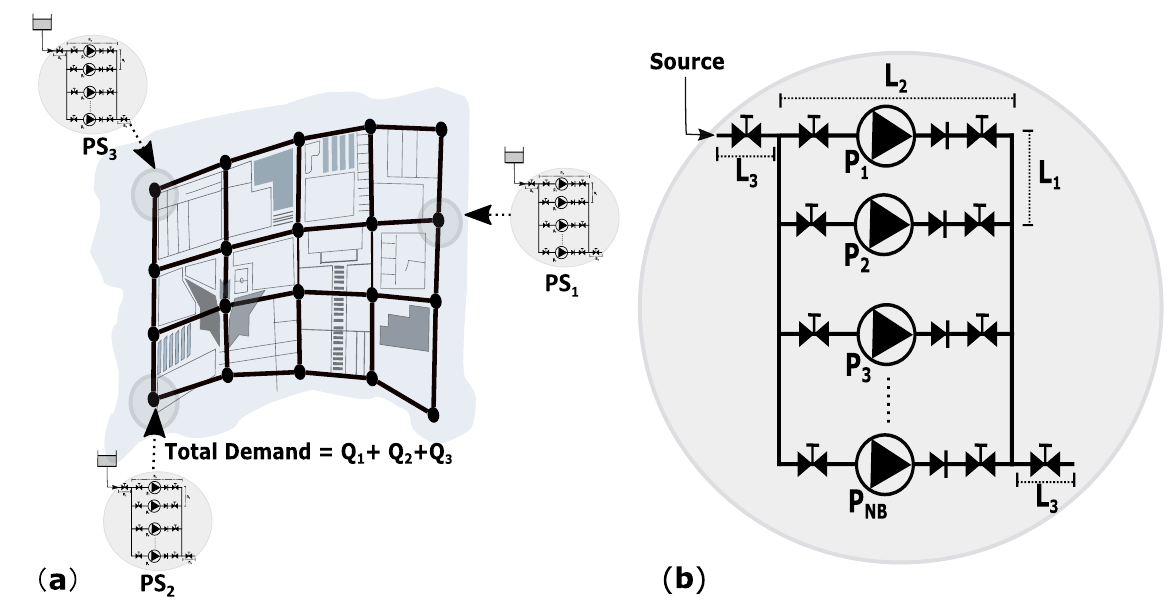
Figure 1. ( a ) General scheme and ( b ) PS modular